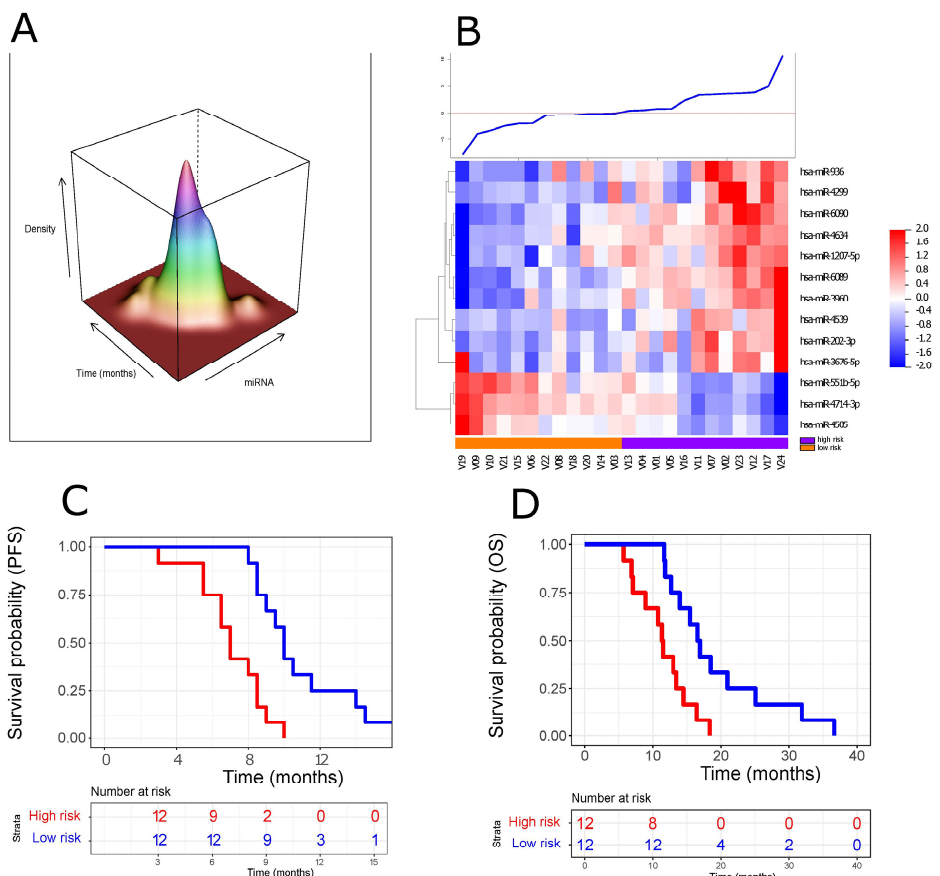
Figure 2. Validation of the ct-miRNA signature. ( A ) Joint density estimation for the signature and time-to-event variable in the validation data set ( x -axis = miRNA model; y -axis = time-to-event; z -axis = density kernel estimate). ( B ) Heatmap of the expression levels of the 13 miRNAs comprising the signature. On the horizontal axis are the respective miRNAs; on the vertical axis are the patient samples ( n = 24). Samples are ranked based on the signature score; even if the rank order differs somewhat between the two heatmaps (training vs. validation), the division between the miRNAs remains clear; the line plot above the heatmap summarizes the score value per sample. ( C ) Kaplan– Meier survival curves for patients predicted to be at a high (blue, n = 12) or low (red, n = 12) risk of progression, taking PFS (progression-free survival) as the endpoint. High-risk patients had a significantly shorter PFS than those at a low risk (log-rank test, p = 0.00026; hazard ratio (HR) = 5.51, 95% confidence interval (CI) 2.03–14.9). ( D ) Kaplan–Meier survival curves taking OS (overall survival) as the clinical endpoint. When risk stratification by the ct-miRNA model was tested for OS, it was significantly shorter for high-risk than low-risk patients (log-rank, p = 0.0021, hazard ratio (HR) = 4.12, 95% confidence interval (CI) 1.57–10.81). High-risk in red, low-risk in